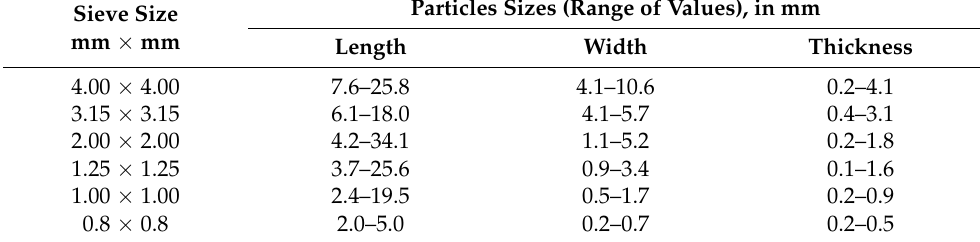
Table 1. Sizes (Range of Values) of Wood